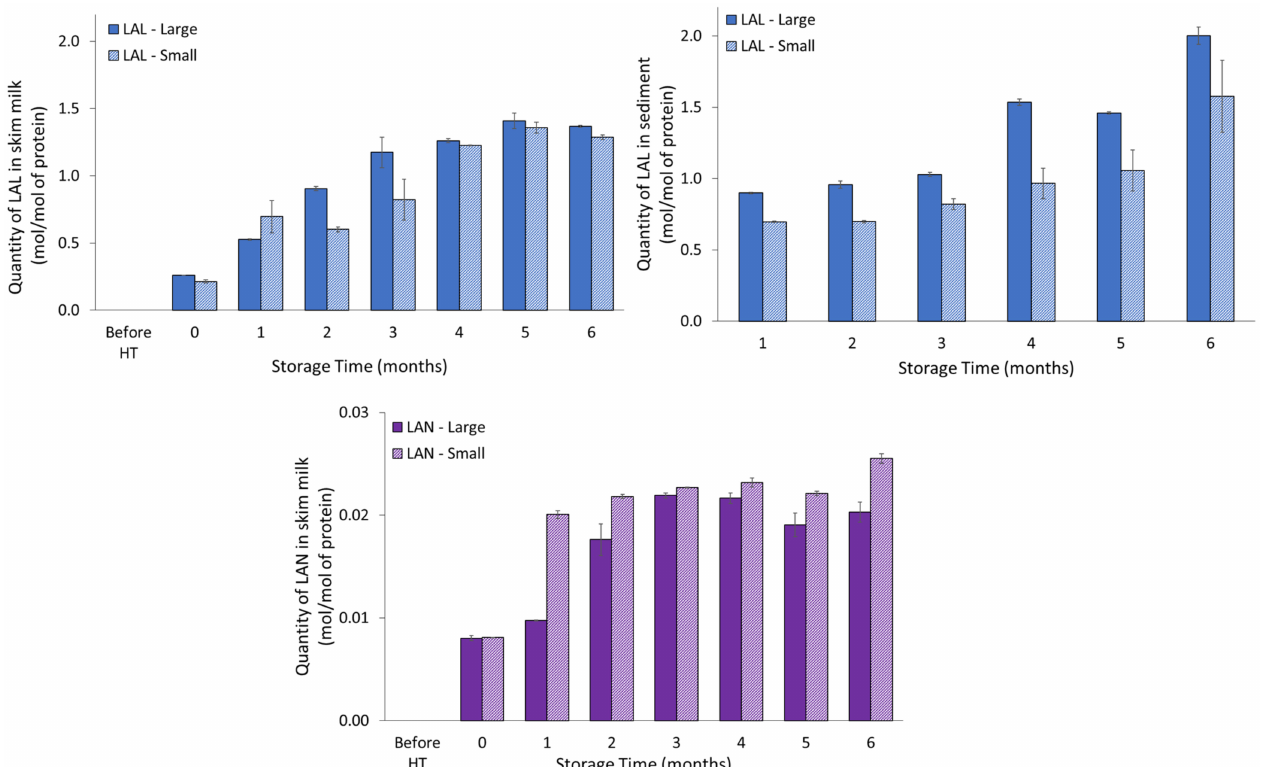
Figure 2. Development in molar levels of LAL and LAN in UHT milk for ( left ) skim milk and ( right ) sediment, and ( below ) LAN in UHT skim milk, representing milk pools with either large or small casein micelles during storage at 40 ◦ C. LAN was below quantification limit in the sediment. ‘Large’ and ‘Small’ indicate UHT milk prepared from raw milk representing large or small casein micelles, respectively.